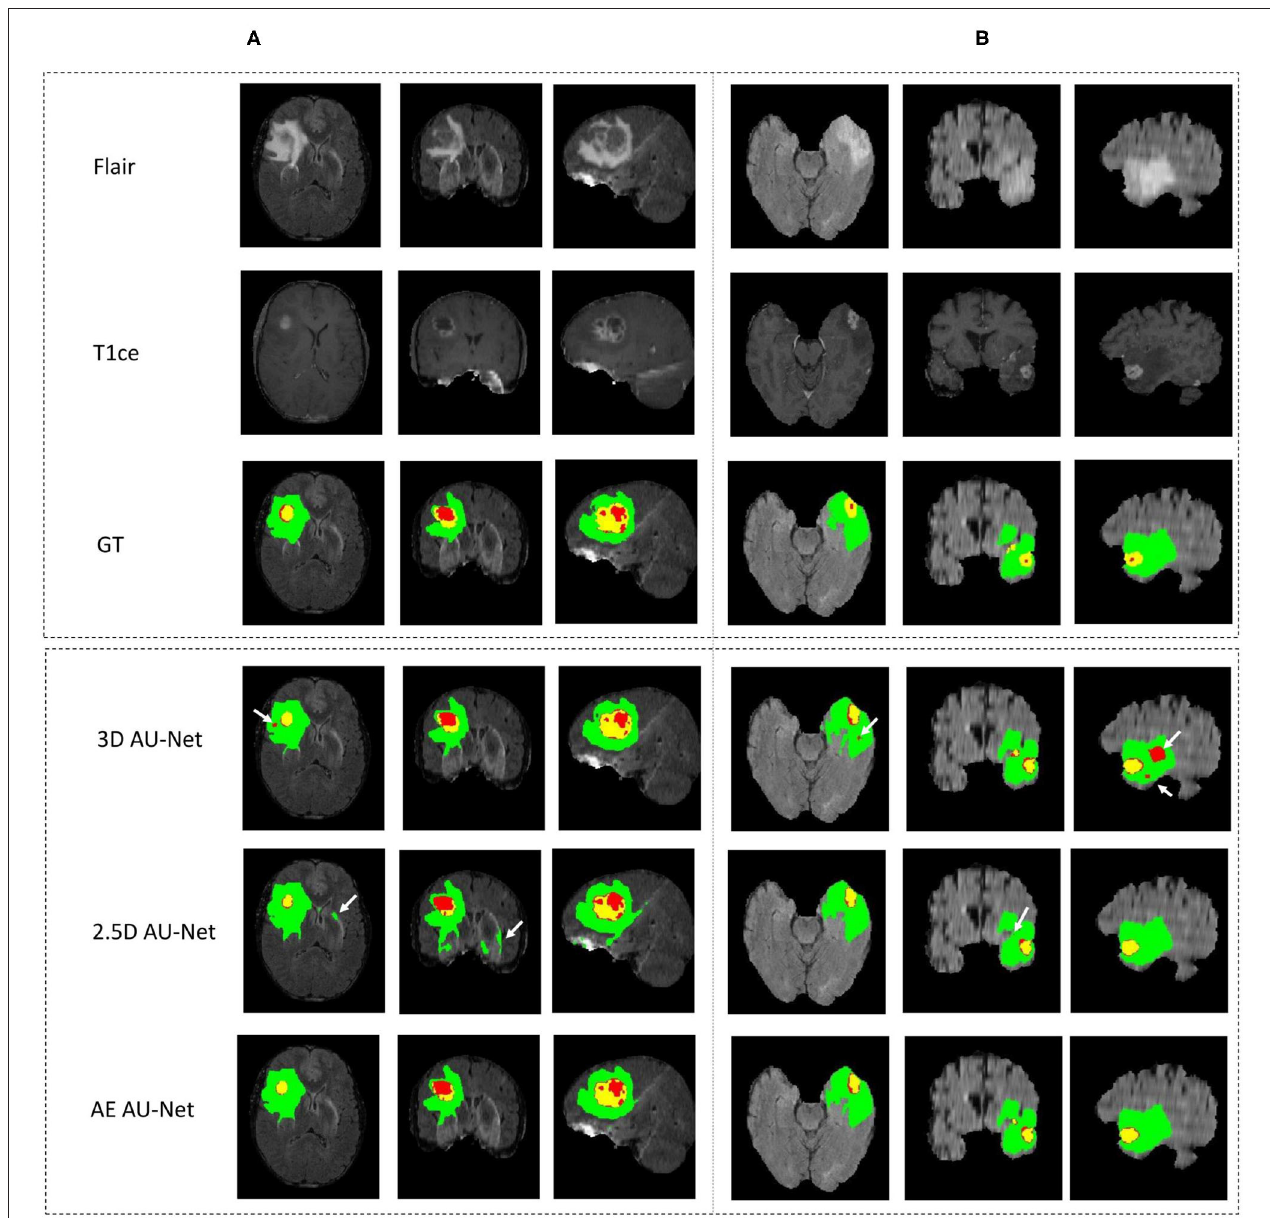
FIGURE 4 | (A,B) Qualitative results. Example of segmentation improvement using our proposed model AE AU-Net in two patients from the BraTS 2019 training dataset. The whole tumor (WT) region includes the union of the three tissues (ED, ET, and NET); the tumor core (TC) region is the union of the necrotic and non-enhancing tumor (red) and enhancing tumor